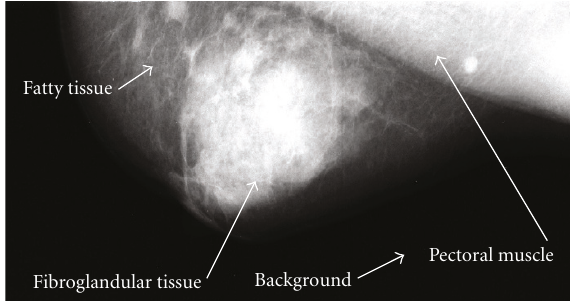
Figure 1: Digitized mammogram with its regions of interest.